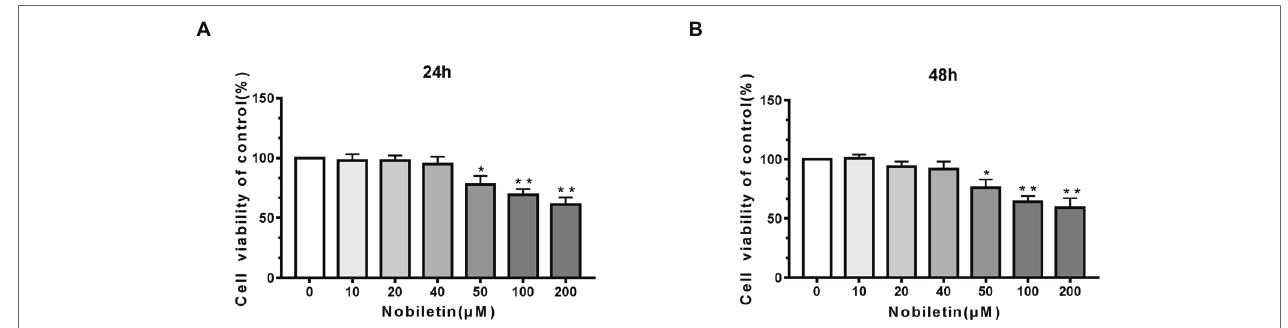
FIGURE 1 | Effect of nobiletin on in vitro cell cytotoxicity. The cells were cultured with increasing concentrations of nobiletin (0, 10, 20, 40, 50, 100 or 200 μM) for 24 (A) and 48 h (B) . Cell viability was measured using a CCK-8 assay. Values represent mean ± SD of three independent experiments. Significant differences are indicated as * p < 0.05, ** p < 0.01, compared to the control